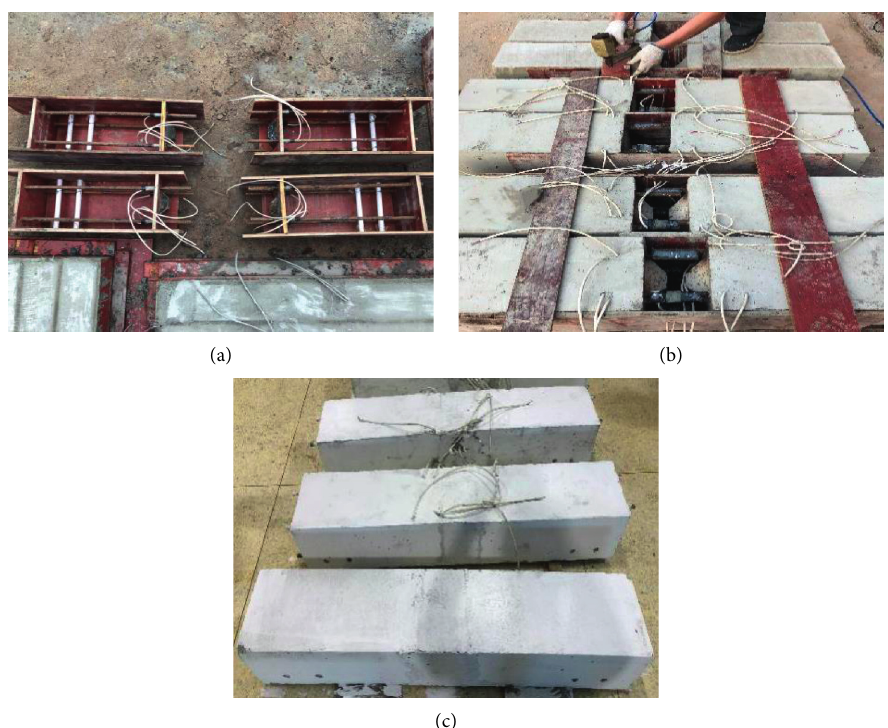
Figure 4: Fabrication of experiment specimens. (a) Formworks of the specimens. (b) Panel-to-panel alignment. (c) Experiment